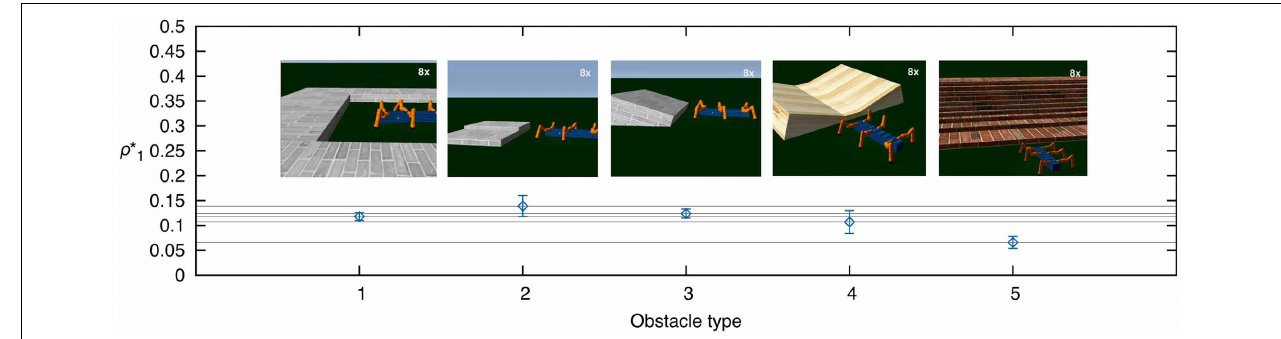
FIGURE 11 | Average learned weights for complex obstacles. We tested five different obstacle types (see Video S2 ) and measured the average learned weights ρ ∗ 1 ( ± SD) for 5 trials each.